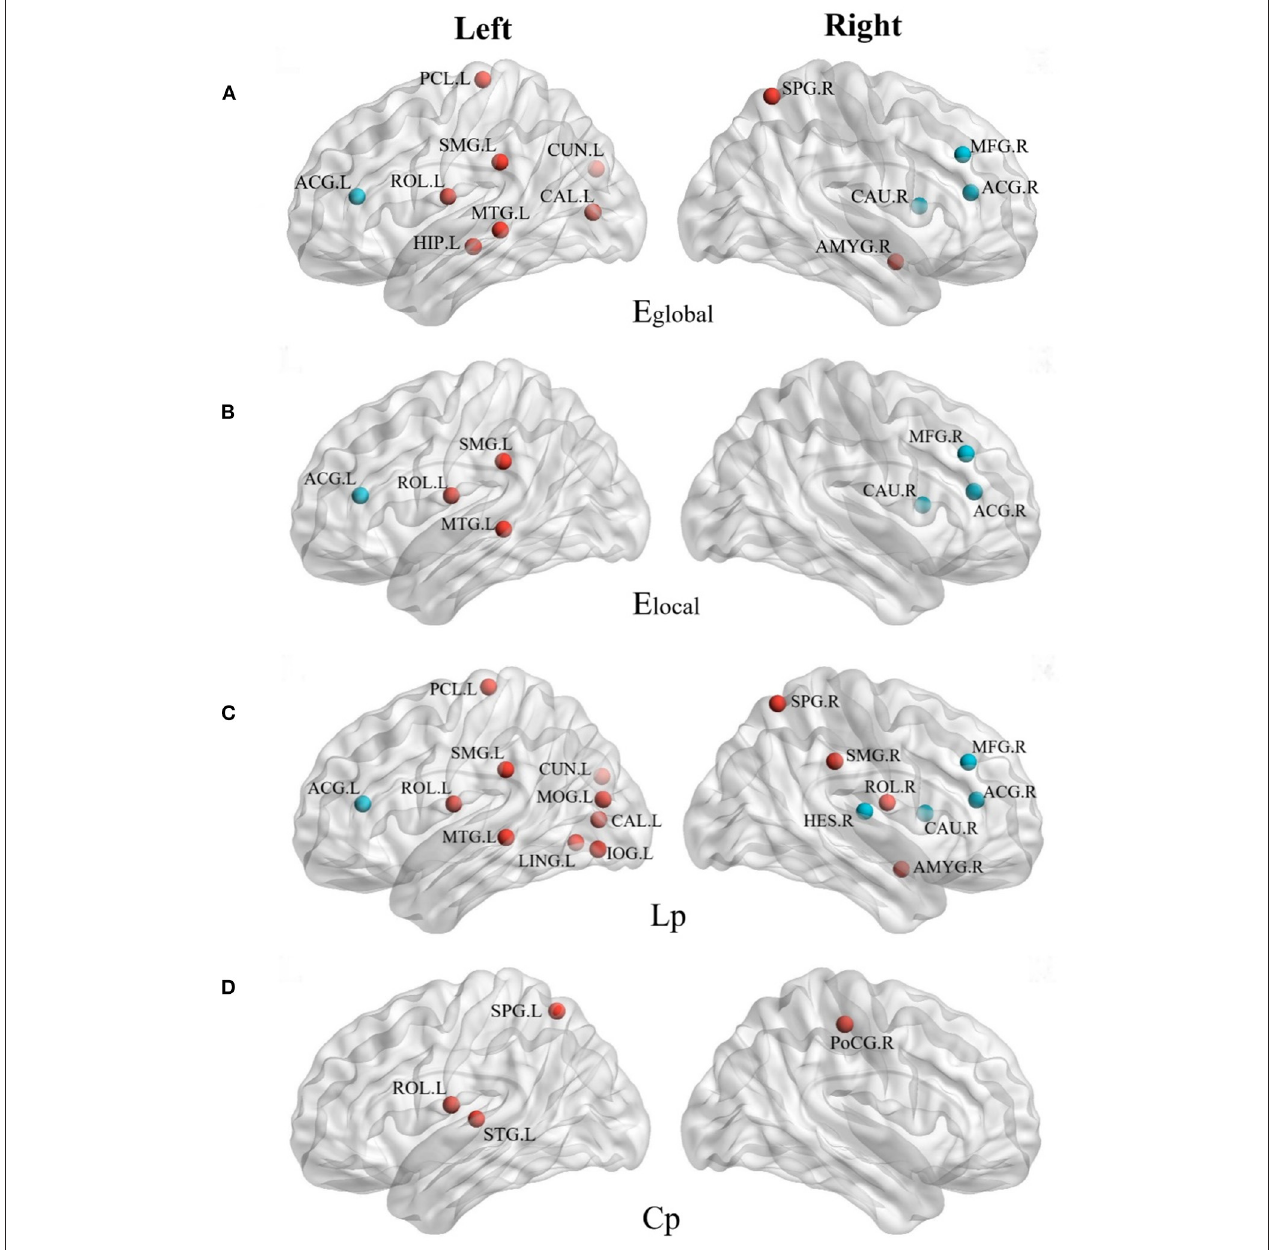
FIGURE 3 | The brain regions with different network parameters in the encephalitis patient group and the normal control group were different ( P < 0.05, red indicates that the network topology attribute was superior in NC, and blue indicates that the network topology attribute was superior in AE). (A) Brain regions with significant differences in global network efficiency (Eglobal) between NC group and AE group; (B) Brain regions with significant differences in local network efficiency (Elocal) between NC group and AE group; (C) The brain regions with shortest characteristic path length (Lp) significantly different between NC group and AE group; (D) Brain regions with significant clustering coefficient of path nodes (Cp) differences between NC group and AE